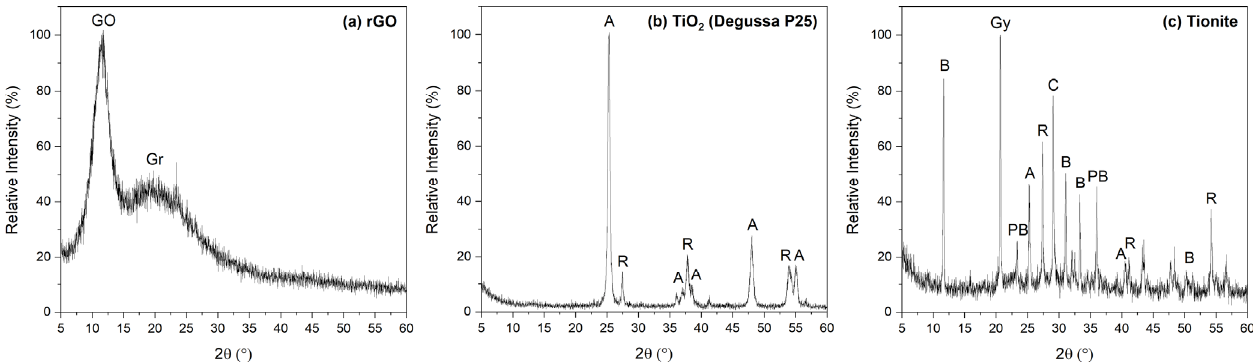
Figure 2. XRD patterns of ( a ) rGO, ( b ) Degussa P25 TiO 2 , and ( c ) tionite. In the figure, GO—graphene oxide, Gr—graphite, A—anatase, R—rutile, C—calcite, Gy—gypsum, B—bassanite, and PB—pseudo-brookite.